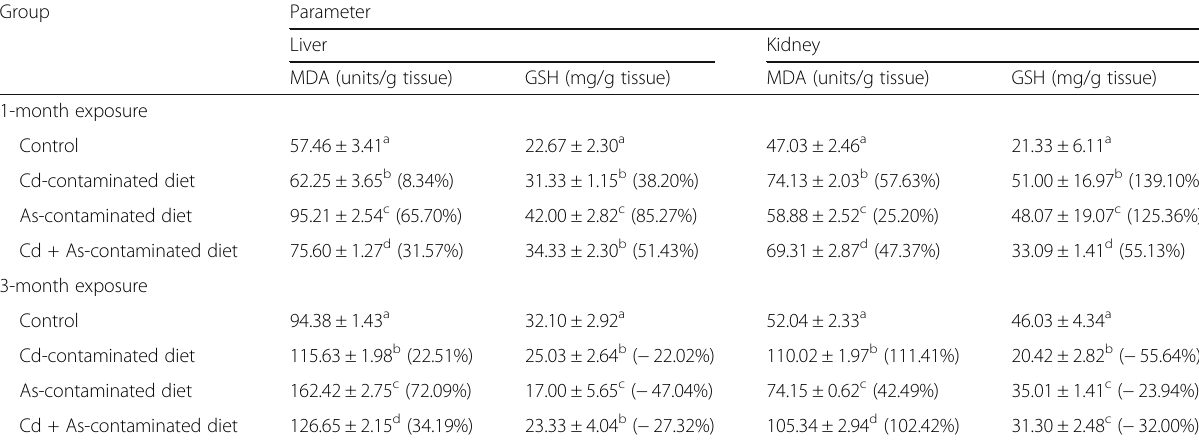
Table 6 Effect of treatment on MDA and GSH in the liver and kidney of experimental rats Group